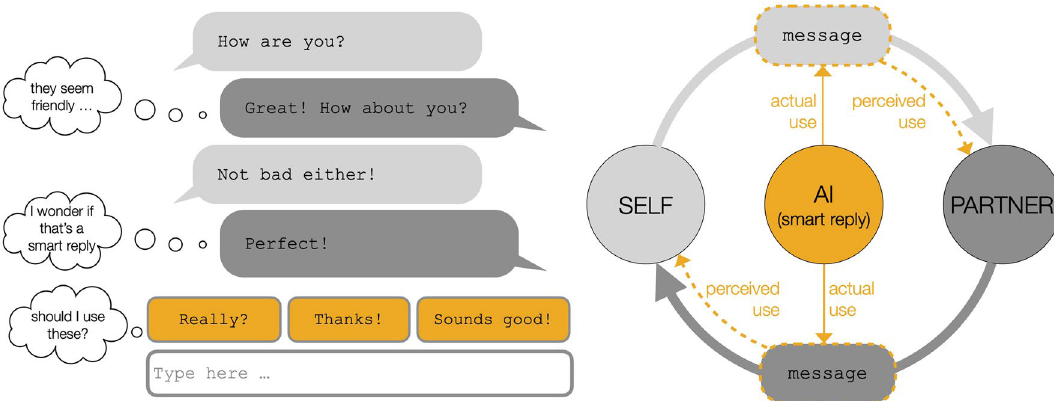
Figure 1. Left side: Example of a message exchange with AI support (i.e. a smart-reply enabled messenger). Typical examples of smart replies and how they might be presented to a user are shown in orange at the bottom. Right side: Abstract representation of the influence of AI on interpersonal communication. Either one or both participants can have access to AI support (e.g. in the form of smart replies). When given access to AI support, participants may choose to use it or not (actual use). However, independent of actual use, participants make assumptions about AI support (perceived use). Both actual use and perceived use influence the overall message exchange and the perceptions people form of each